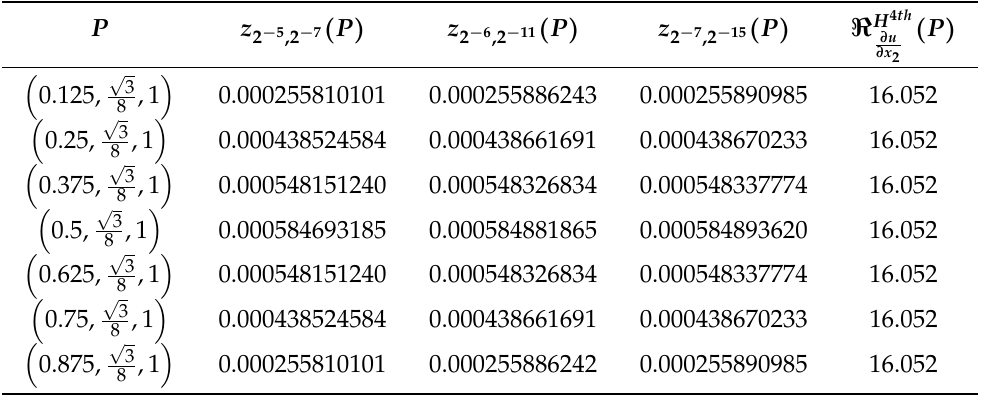
Table 5. The numerical solution z h , τ at seven points when t = 1, and the convergence orders obtained ) for the Example by H 4 th ( ∂ u ∂ x 2